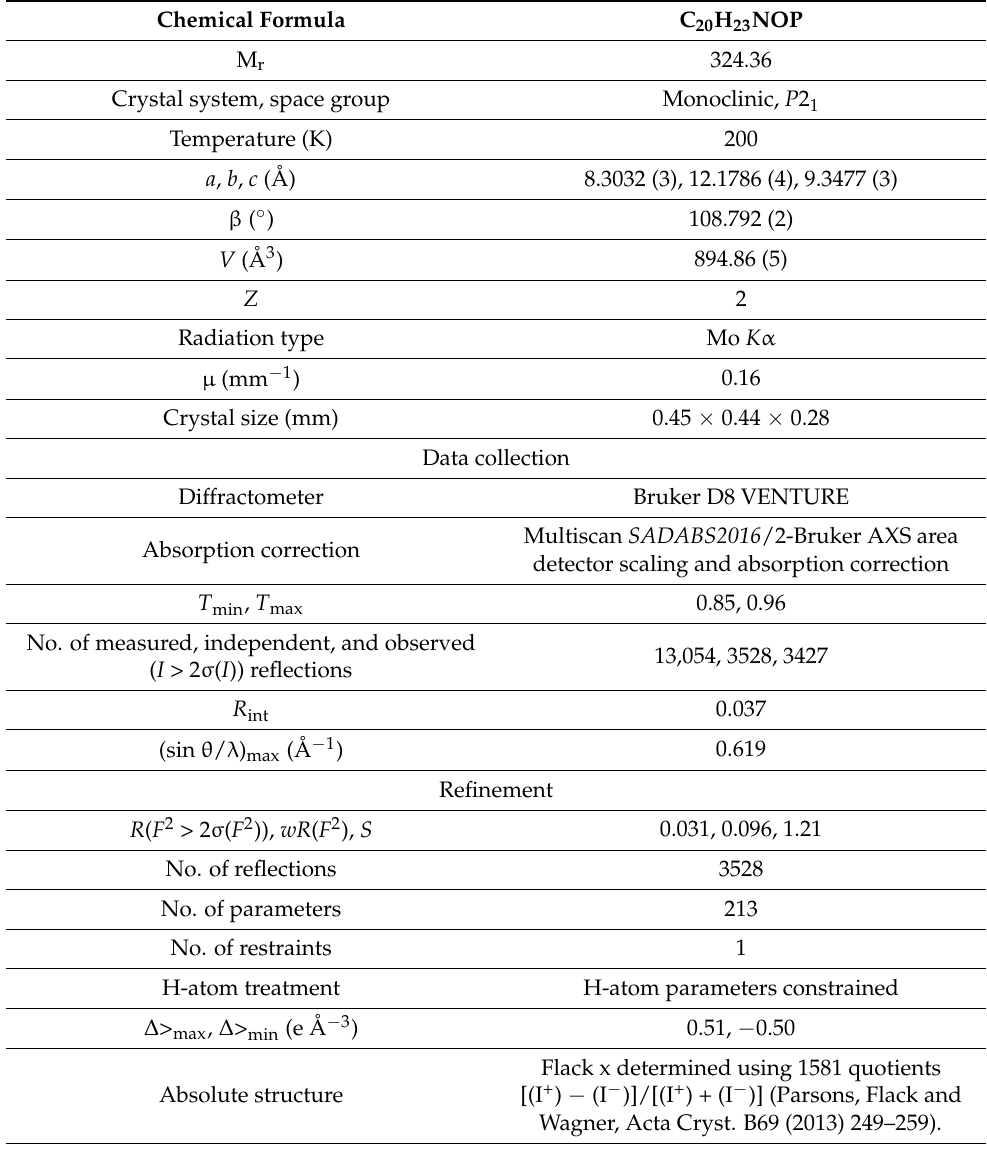
Table 1. Crystal data for compound 8